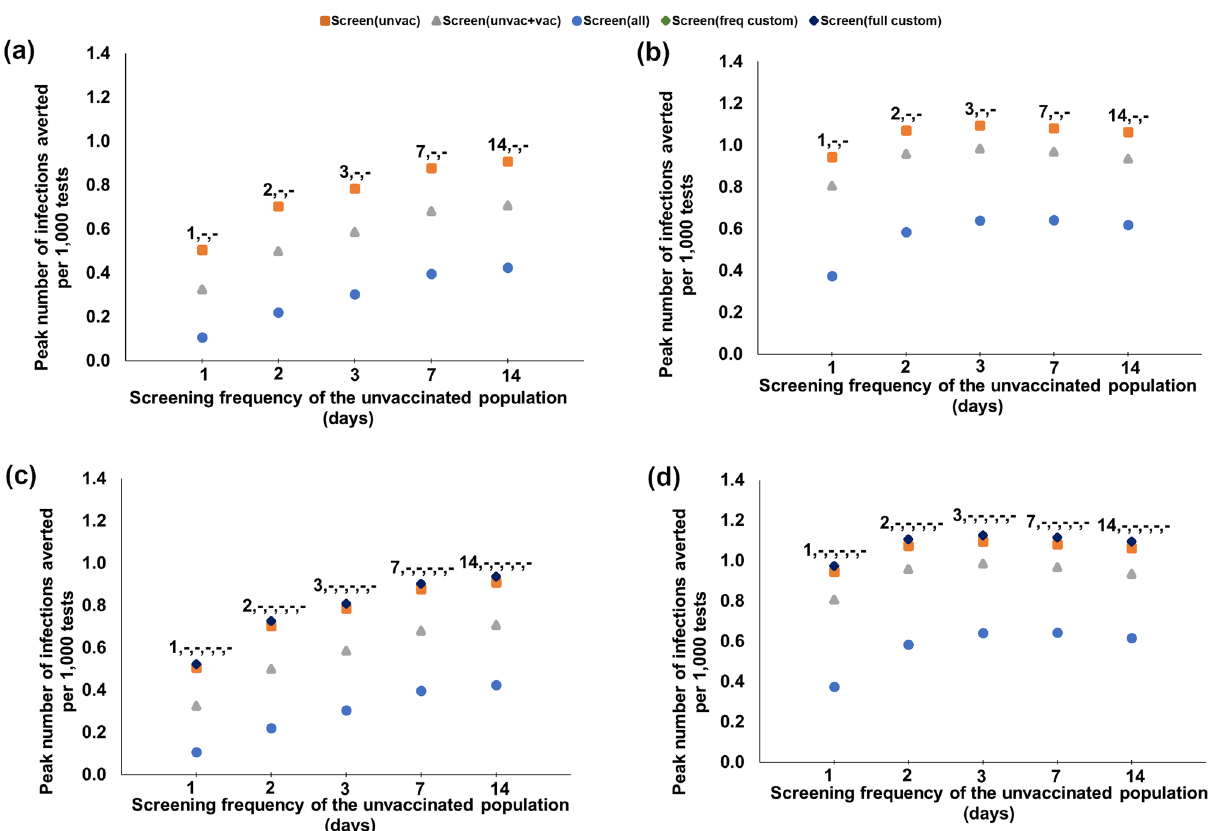
Figure 4. Peak number of infections averted per 1000 tests with respect to the screening frequency of the unvaccinated, for various customized screening strategies under 64% boosted, 18% vaccinated, 18% unvaccinated, and various Omicron proportions. ( a , b ) Screening is customized based on vaccination status only; the label represents the screening frequency for unvaccinated, vaccinated, boosted. ( c , d ) Screening is customized based on both vaccination status and faculty versus students; the label represents the screening frequency for unvaccinated students, vaccinated students, boosted students, unvaccinated faculty, vaccinated faculty, boosted faculty. (“–” indicates no